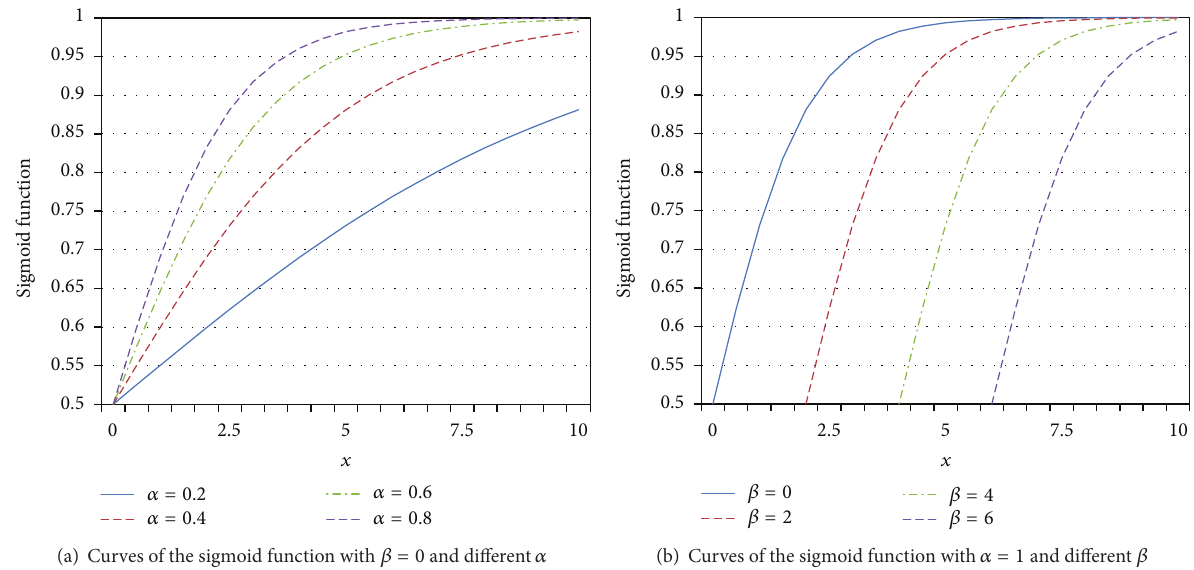
(b) Curves of the sigmoid function with 𝛼 = 1 and different 𝛽 Figure 2: Curves of the sigmoid